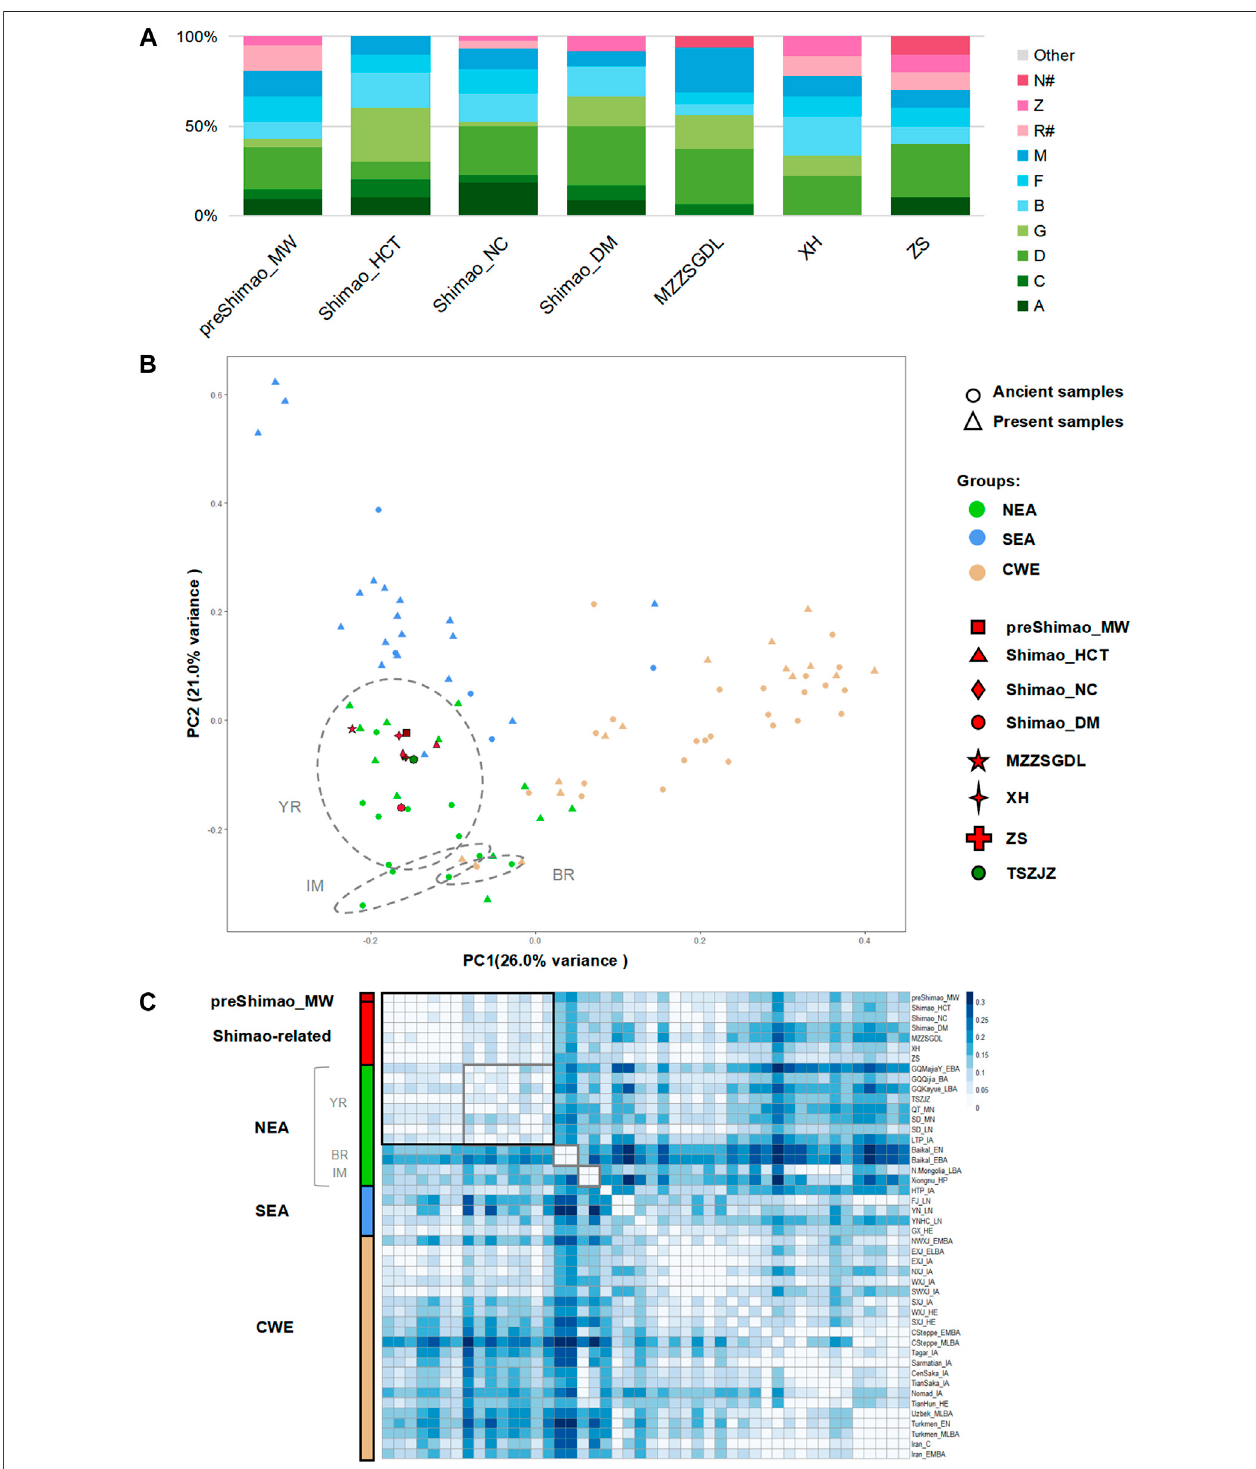
FIGURE2| ThegeneticanalysisofancientpopulationsinnorthernShaanxiProvince. (A) Haplogroupfrequency.Thehaplogroupswithgreenarethosecommonin northeastern Asians (NEAs), and those with blue are common in southeastern Asians (SEAs). The haplogroups absent from Shimao-related populations are grouped in “ Other. ” The haplogroups R # and N # represent the haplotypes shown in East Eurasians (such as haplotype R+16189, sub-haplogroups R11 and N9, which were observed in the Shimao-related populations). (B) Principal Component Analysis (PCA) based on the haplogroup frequencies. The circle and triangle shapes represent ancient and present-day populations, respectively. The colored and shaped symbols correspond to Figure 1A . The grey circles represent the ancient